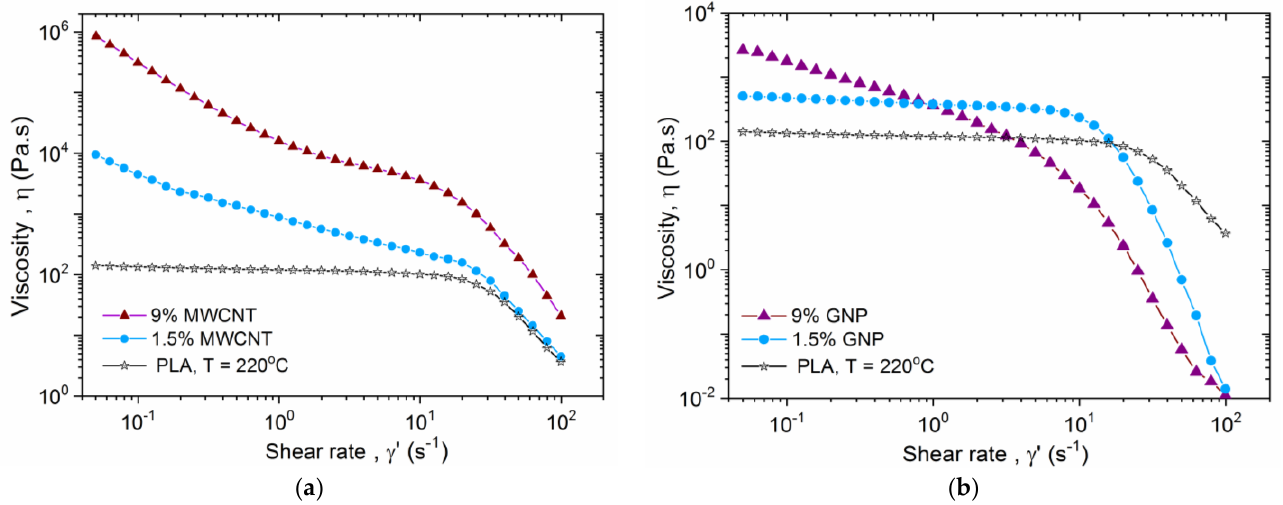
Figure 3. Viscosity vs. shear rate of ( a ) MWCNT/PLA and ( b ) GNP/PLA nanocomposites at filler contents of 0, 1.5 and 9 wt.%, at 220 °C.